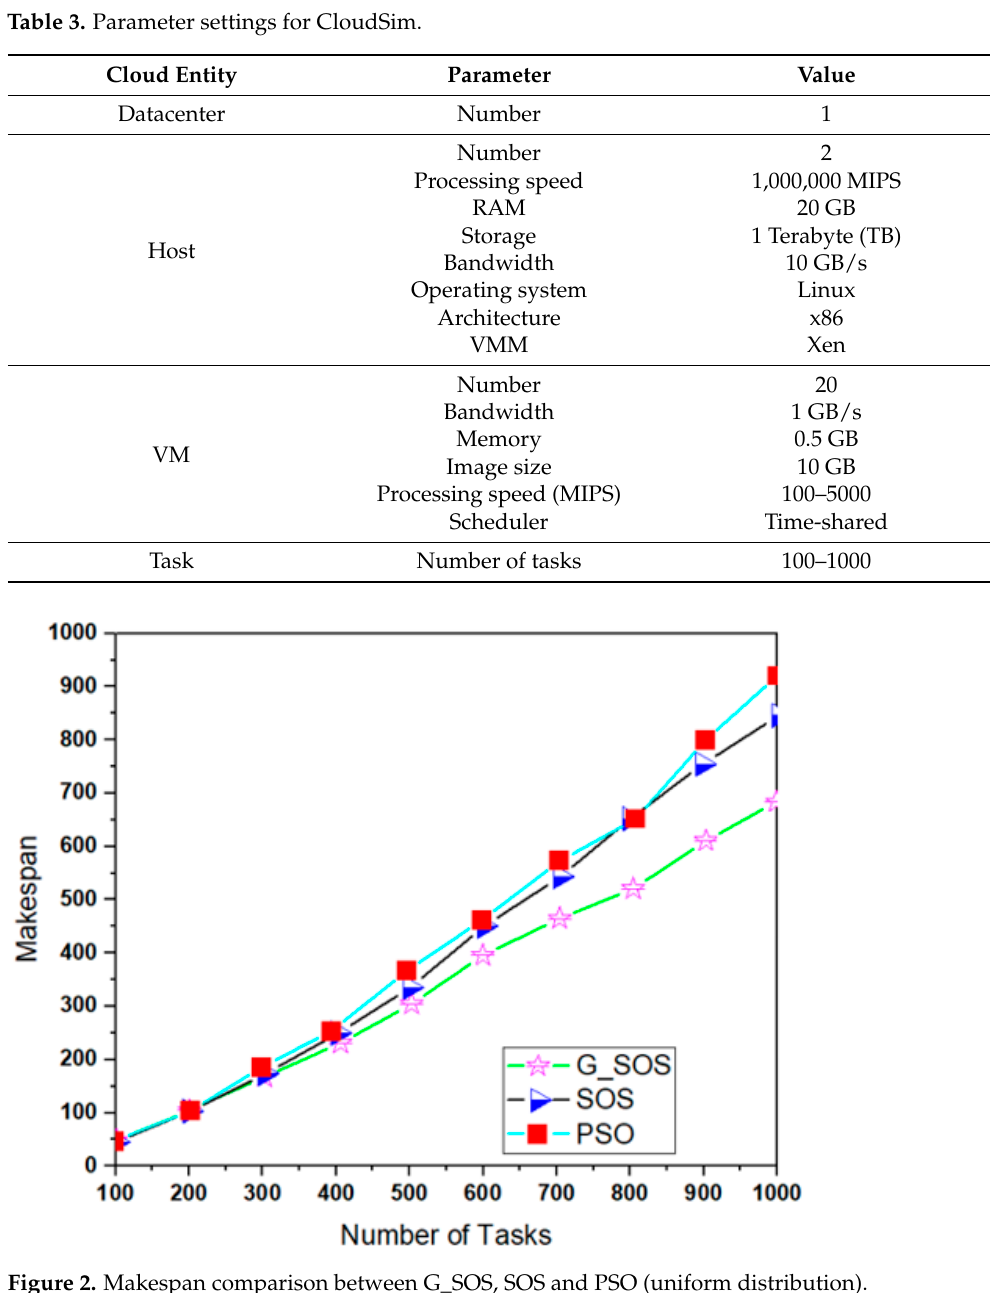
Figure 3. Average cost corresponding to the number of tasks.